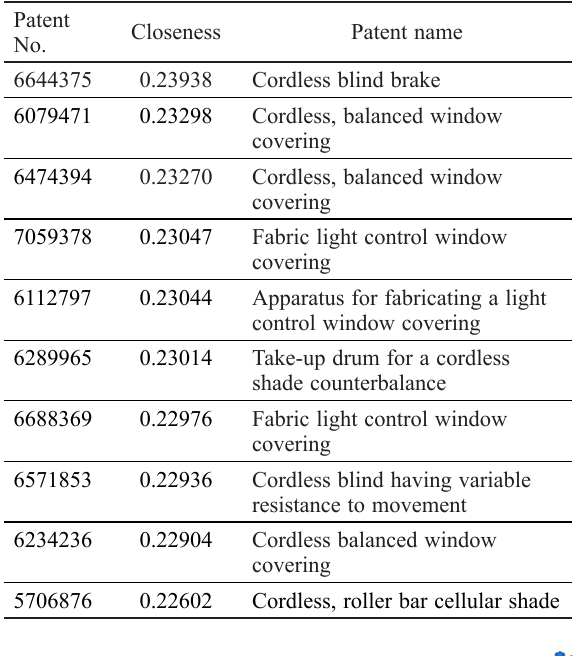
Table 6. Closeness centrality of the top 10 patents in the technology field Patent No.